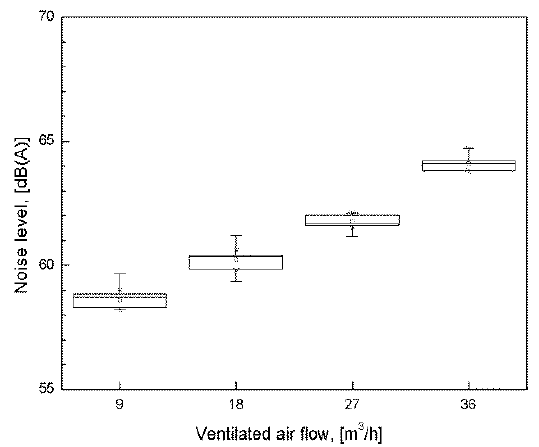
Figure 18. Noise levels in the test room (with background ventilation, ALTAIR with sound absorber – 10 s time step).